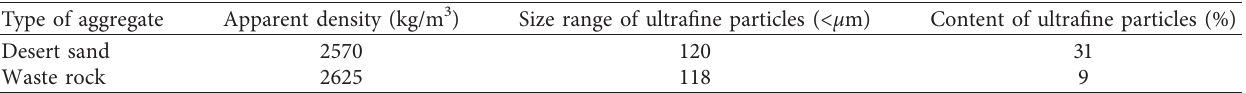
Table 7: Range and content of ultrafine particles of fill